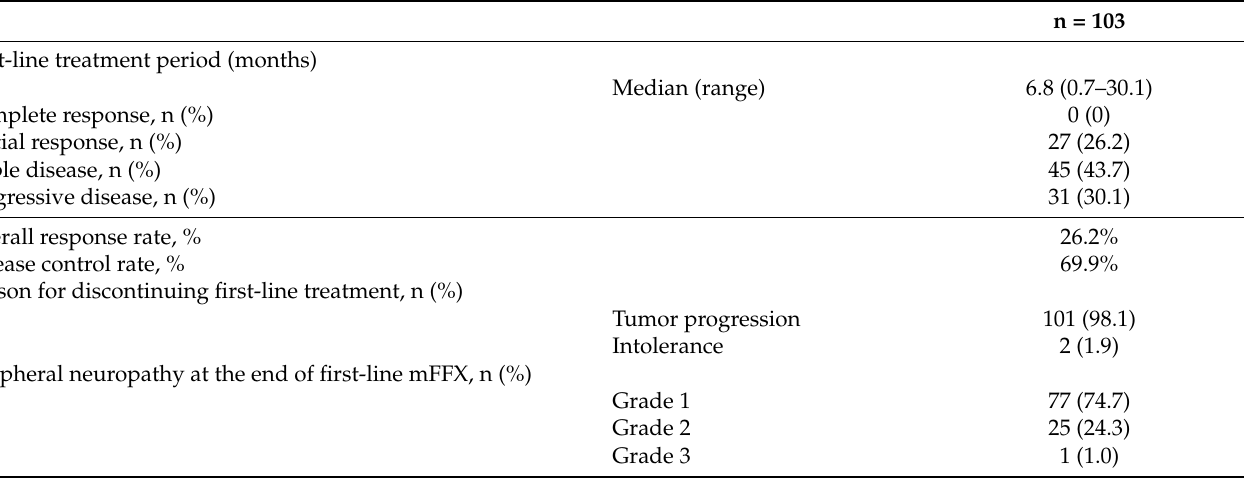
Table 2. Treatment outcomes and adverse events of first-line